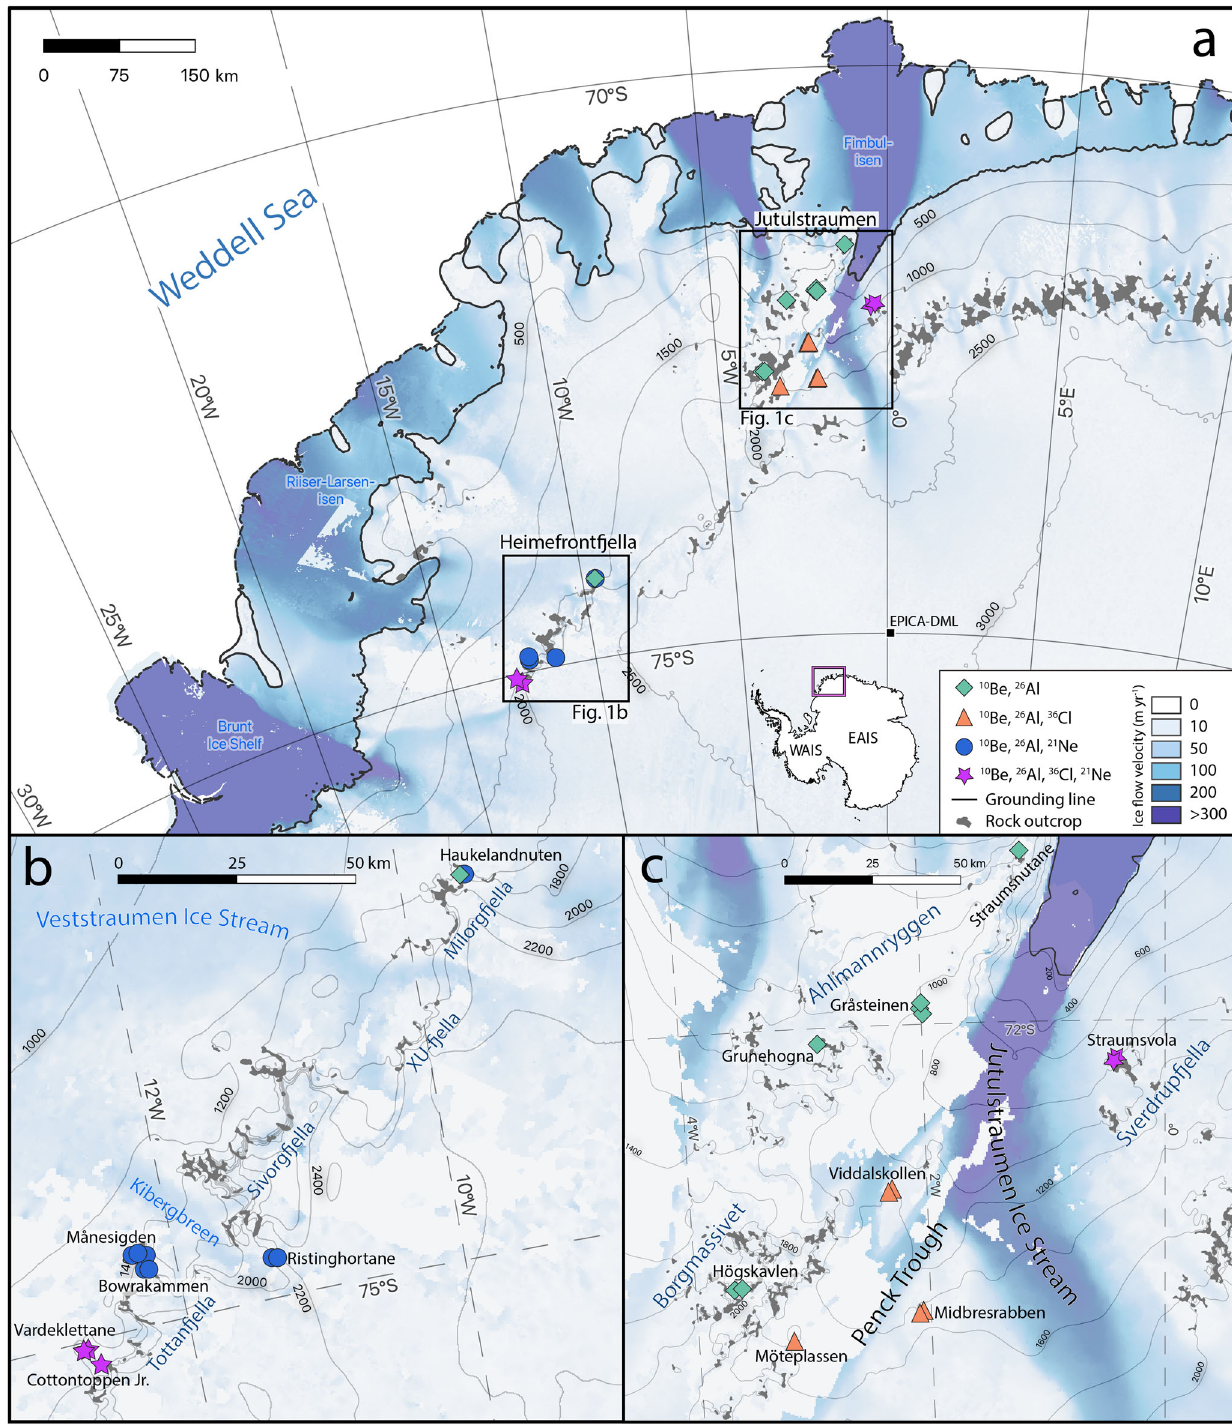
Fig. 1 Study area. a Overview map of study areas in western Dronning Maud Land (see inset; WAIS = West Antarctic Ice Sheet, EAIS = East Antarctic Ice Sheet). Boxes outline sample site locations in b Heimefrontfjella, and c along Jutulstraumen and Penck Trough ice streams. MEASURES present-day ice- fl ow velocities 41 . All map elements were acquired through the Quantarctica 3 GIS package provided by the Norwegian Polar Institute 75